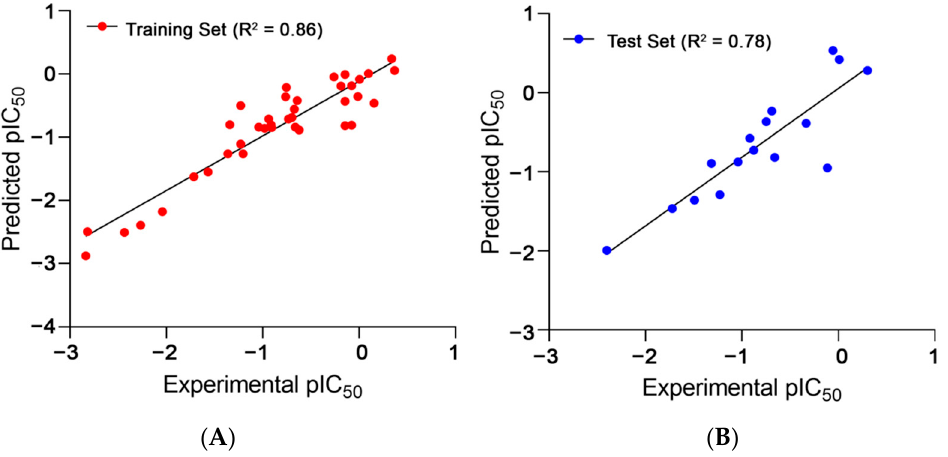
Figure 1. Observed and predicted TLR7 antagonistic activities of ( A ) training set and ( B ) test set compounds for the developed 2D ‐ QSAR model.